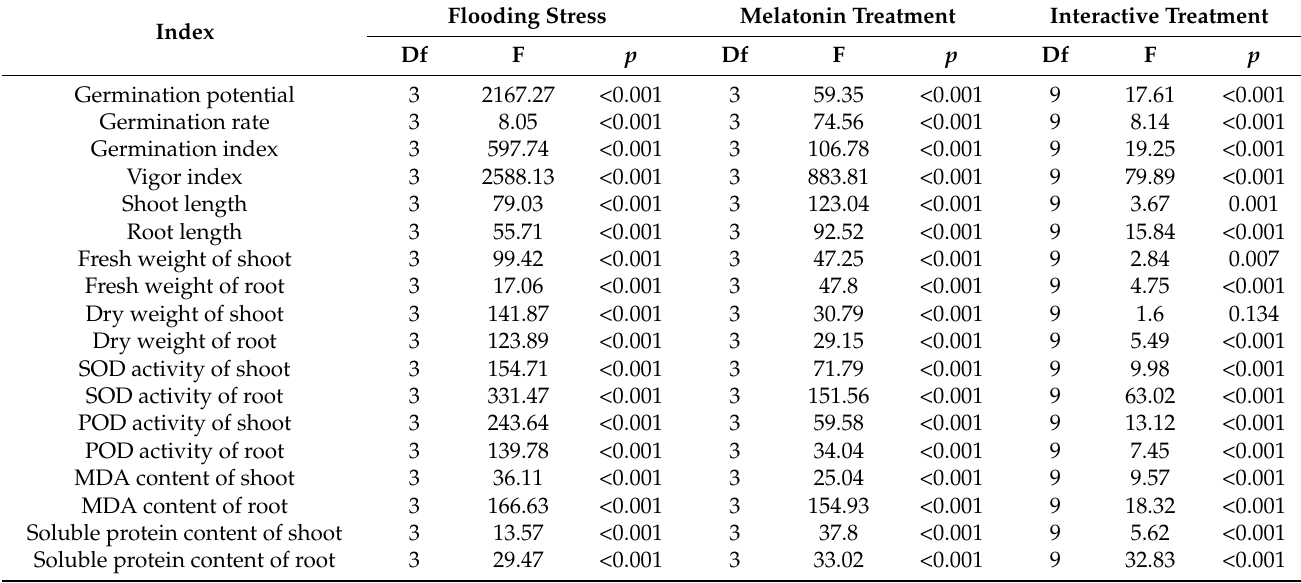
Table 1. Two-way ANOVA of melatonin and flooding stress.